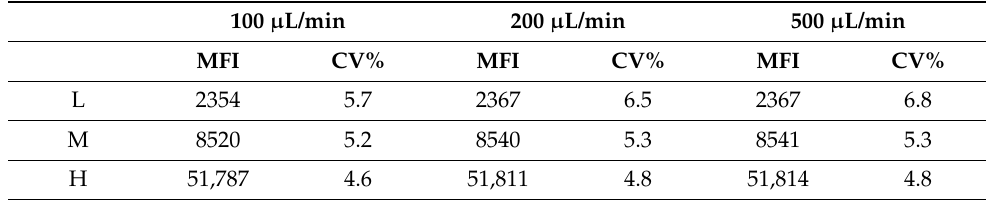
Table 5. Corrected values for flat-top laser beam profile.